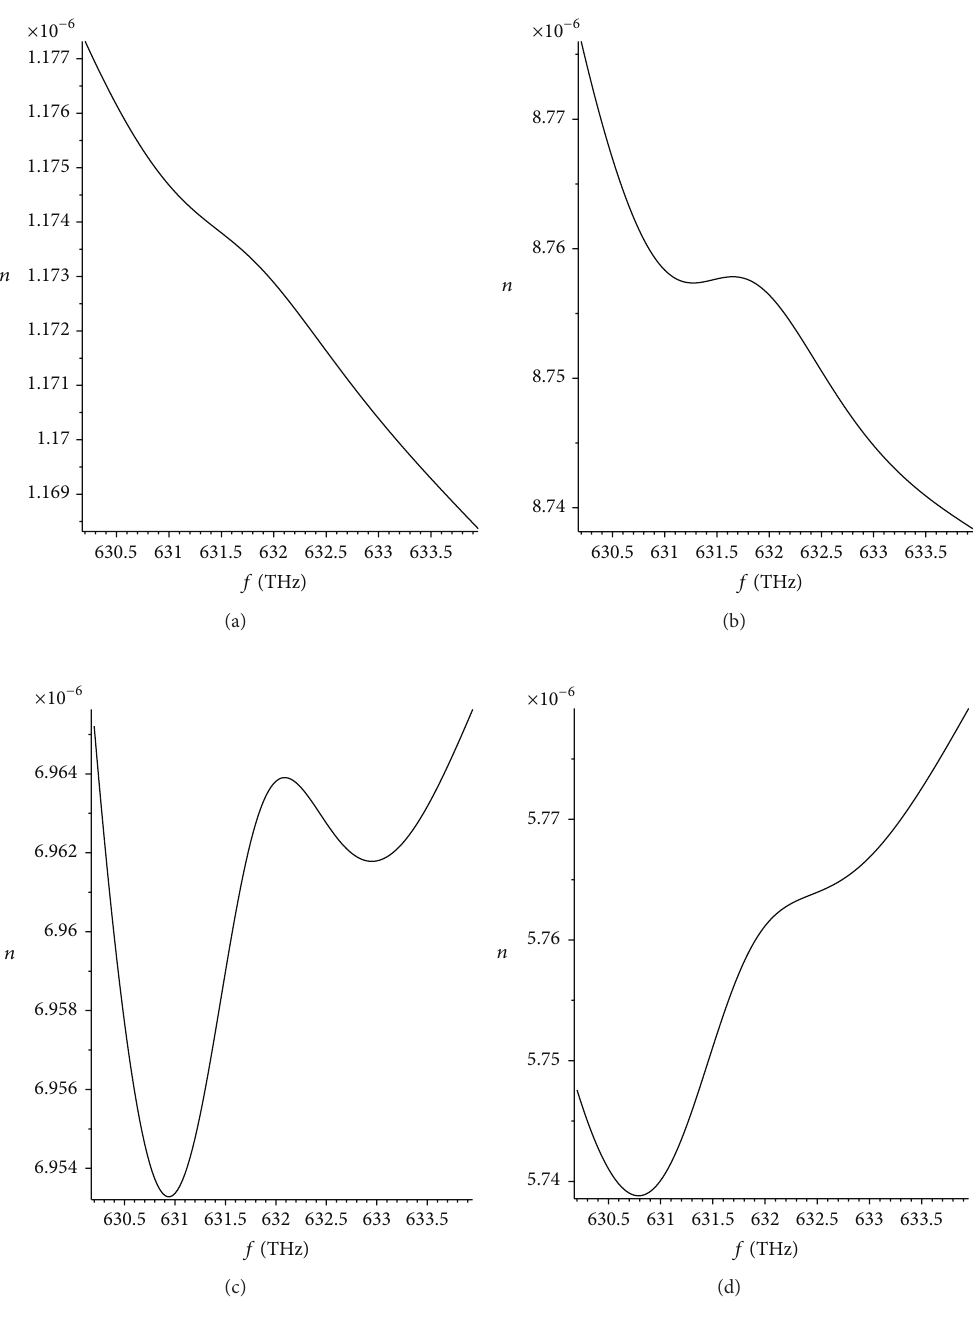
Figure 3: The real part of the effective refractive index, 𝑛 , versus the frequency for different dielectric core thicknesses. In (a), 𝑡 = 30 nm, (b) 40nm, (c) 50nm, and (d) 60